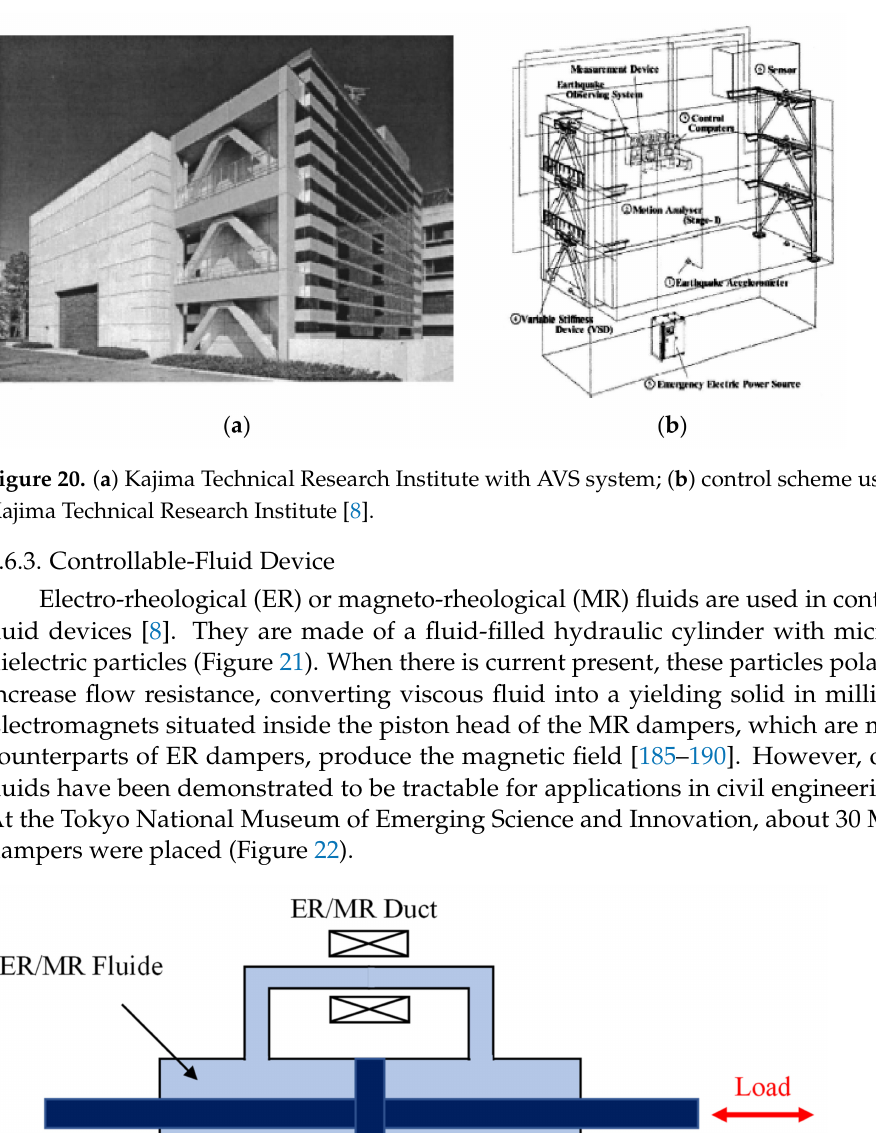
Figure 19. Variable-Orifice Dampers.